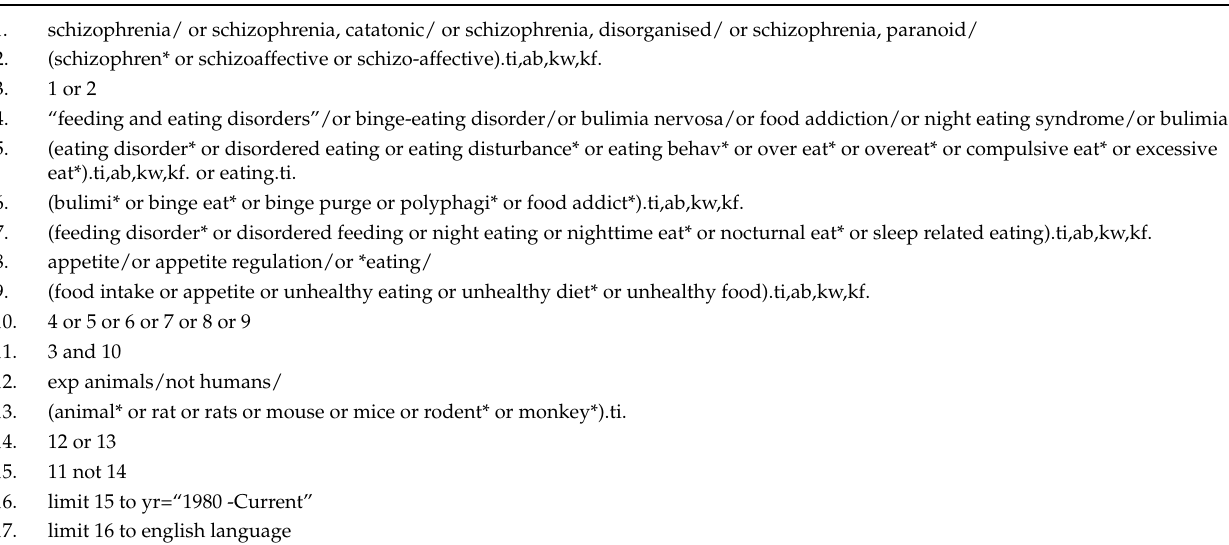
Table 1. Search strategy for Ovid MEDLINE ® ALL 1946 to 15 February